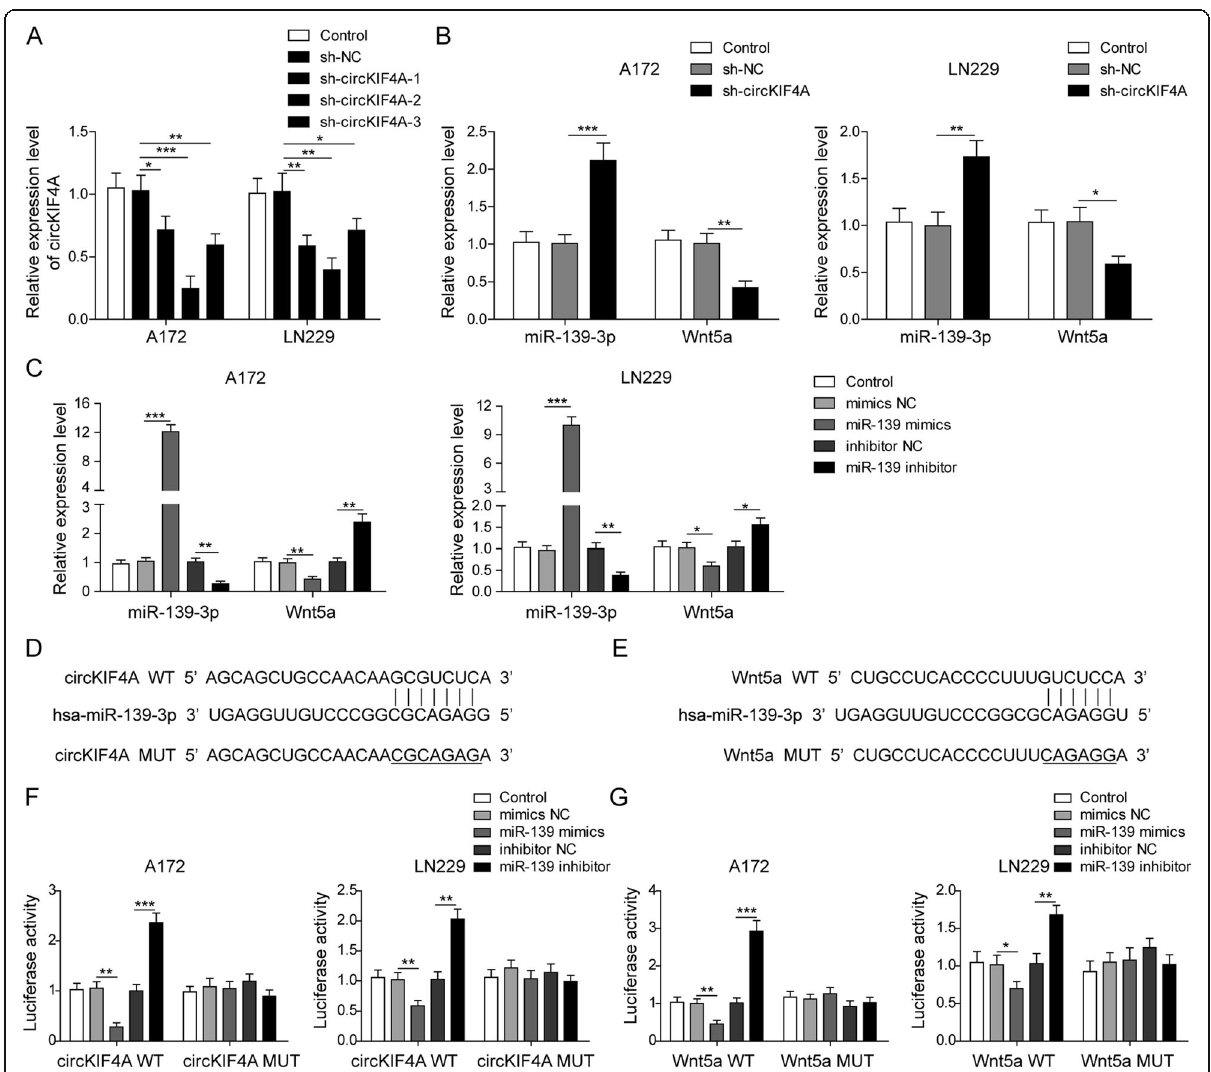
Fig. 2 circKIF4A directly targeted miR-139-3p to promote the expression of Wnt5a in A172 and LN229 cells. a The expression level of circKIF4A was detected by qRT-PCR in A172 and LN229 cells transfected with sh-circKIF4A-1, sh-circKIF4A-2 and sh-circKIF4A-3. b miR-139-3p and Wnt5a were detected by qRT-PCR in A172 and LN229 cells transfected with sh-circKIF4A-2. c The expression level of miR-139-3p and Wnt5a were detected by qRT-PCR in A172 and LN229 cells transfected with miR-139-3p mimics or inhibitor. d Schematic representation of binding sites between circKIF4A and miR-139-3p predicted by StarBase software. e Schematic representation of binding sites between miR-139-3p and Wnt5a predicted by StarBase software. f Luciferase activity assay was performed after co-transfection with circKIF4A reporter plasmid and miR-139-3p into A172 and LN229 cells. g Luciferase activity assay was performed after co-transfection with Wnt5a reporter plasmid and miR-139-3p into A172 and LN229 cells. * p < 0.05, ** p < 0.01, *** p <